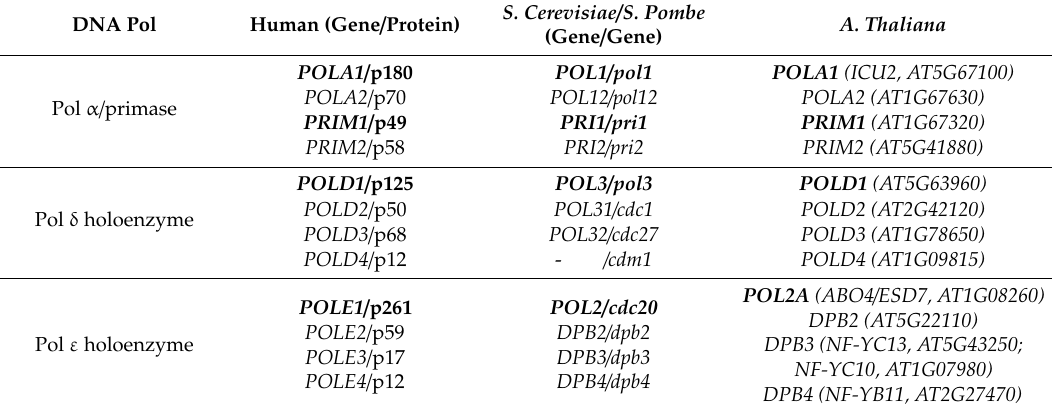
Table 1. Nomenclature for replicative DNA polymerases (Pols) in human, yeast ( Saccharomyces cerevisiae and S. pombe ), and plant ( Arabidopsis thaliana ) orthologues. Catalytic subunits are indicated in bold